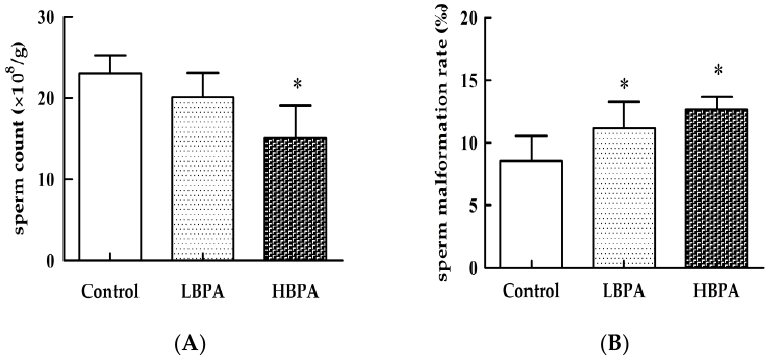
Figure 2. Effects of perinatal BPA exposure on mean body weight, food intake, and water intake in male offspring mice. Changes in mean body weight ( A ), food intake ( B ), and water consumption ( C ).